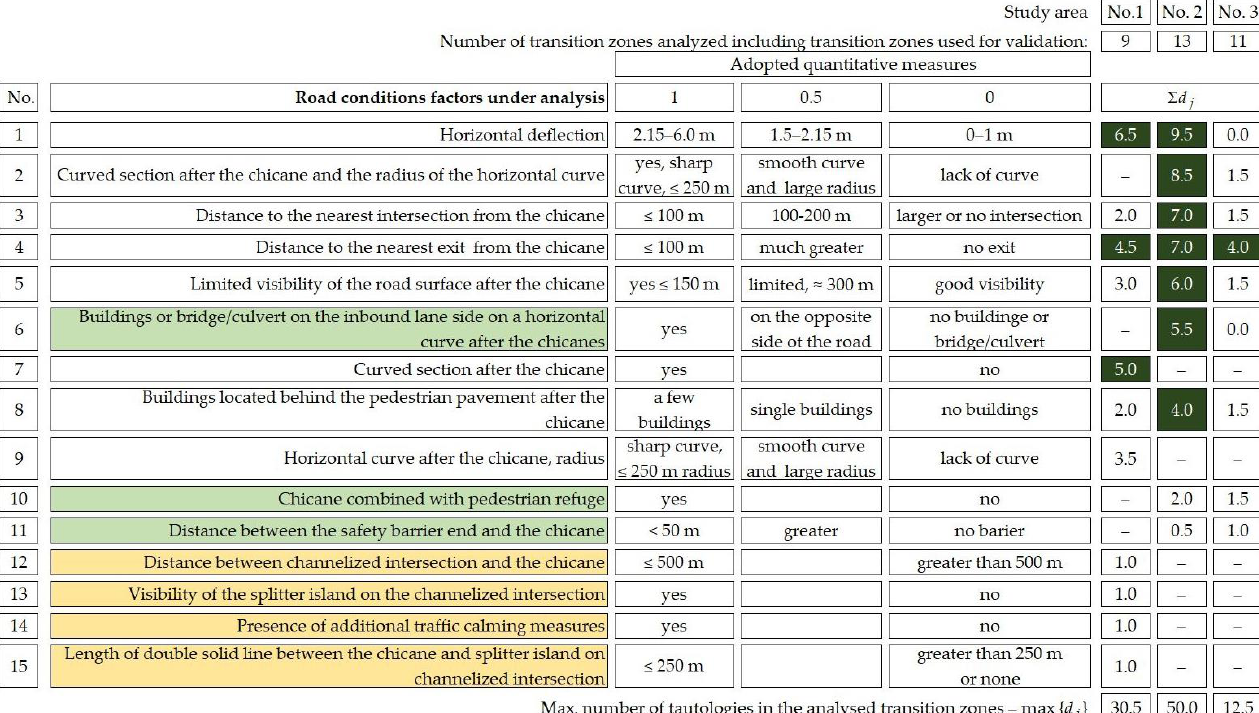
Figure 13. Comparison of initially adopted RC factors in the analysed study areas, based on [26,27]. Legend: d j — number of confirmed logical tautologies in all the analysed transition zones in a given study area; (–) indicates that the factor was excluded from consideration in a given study area.